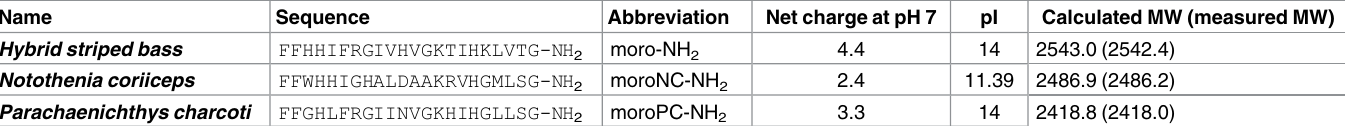
Table 1. Synthetic peptides.